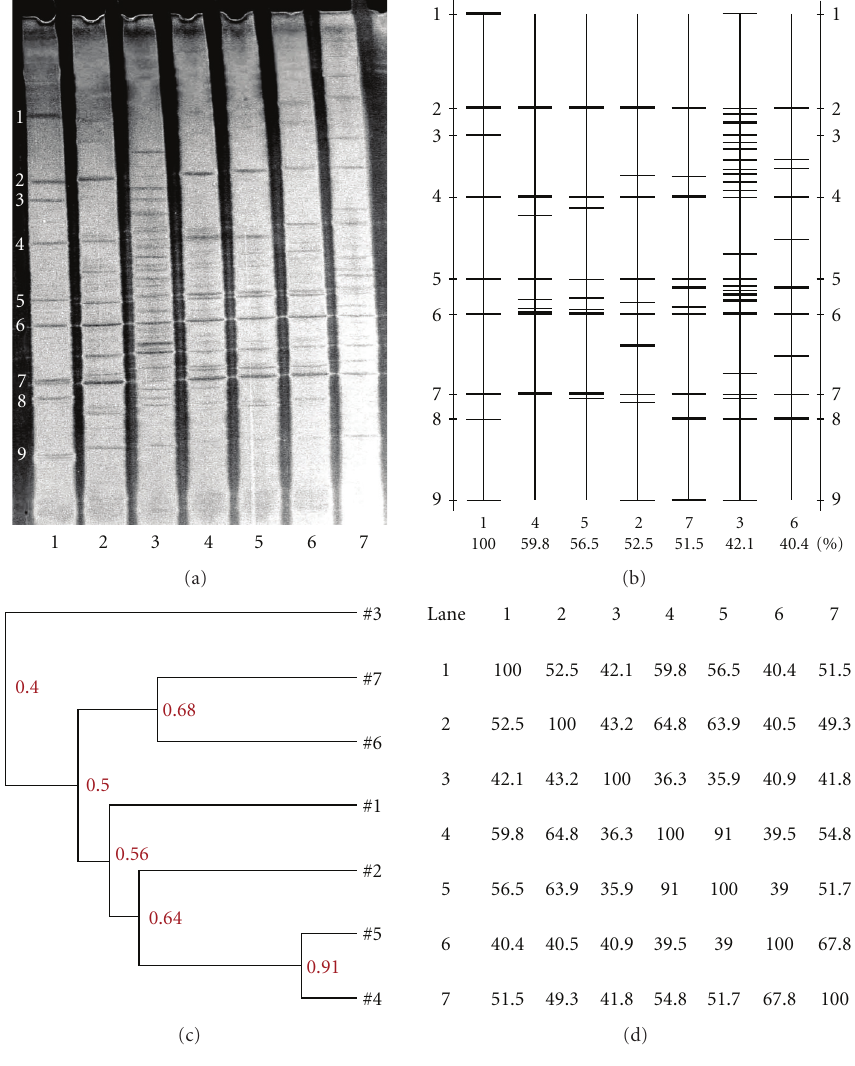
Figure 2: (a) DGGE profiles of V 3 amplicons in the fermentation broth of cecal microbiota from weaned rats in the presence of glucose (2), culture solution (3), CYP 4 (4), CYP 3 (5), CYP 2 (6), and CYP 1 (7) for 48 hours. The standard strains (1) listed in order from the top of the gel to the bottom were Staphylococcus aureus, Lactobacillusamylovorus , Lactobacillus salivarius , Ruminococcus forques , Bacillus subtilis,E.coli O157: H7, Clostridium perfringens , Salmonella typhimurium and Clostridium lituseburens, respectively. (b) Sketch map of the DGGE profiles. (c) and (d) Similarity indices of the DGGE profiles. All of the four samples from each treatment group were pooled into a single sample. Table 9: E ff ects of Chinese Yam polysaccharide (CYP) on he ntestinal bacterial population in fermentation broth. DNA bands co-migrating with Culture solution Glucose CYP 4